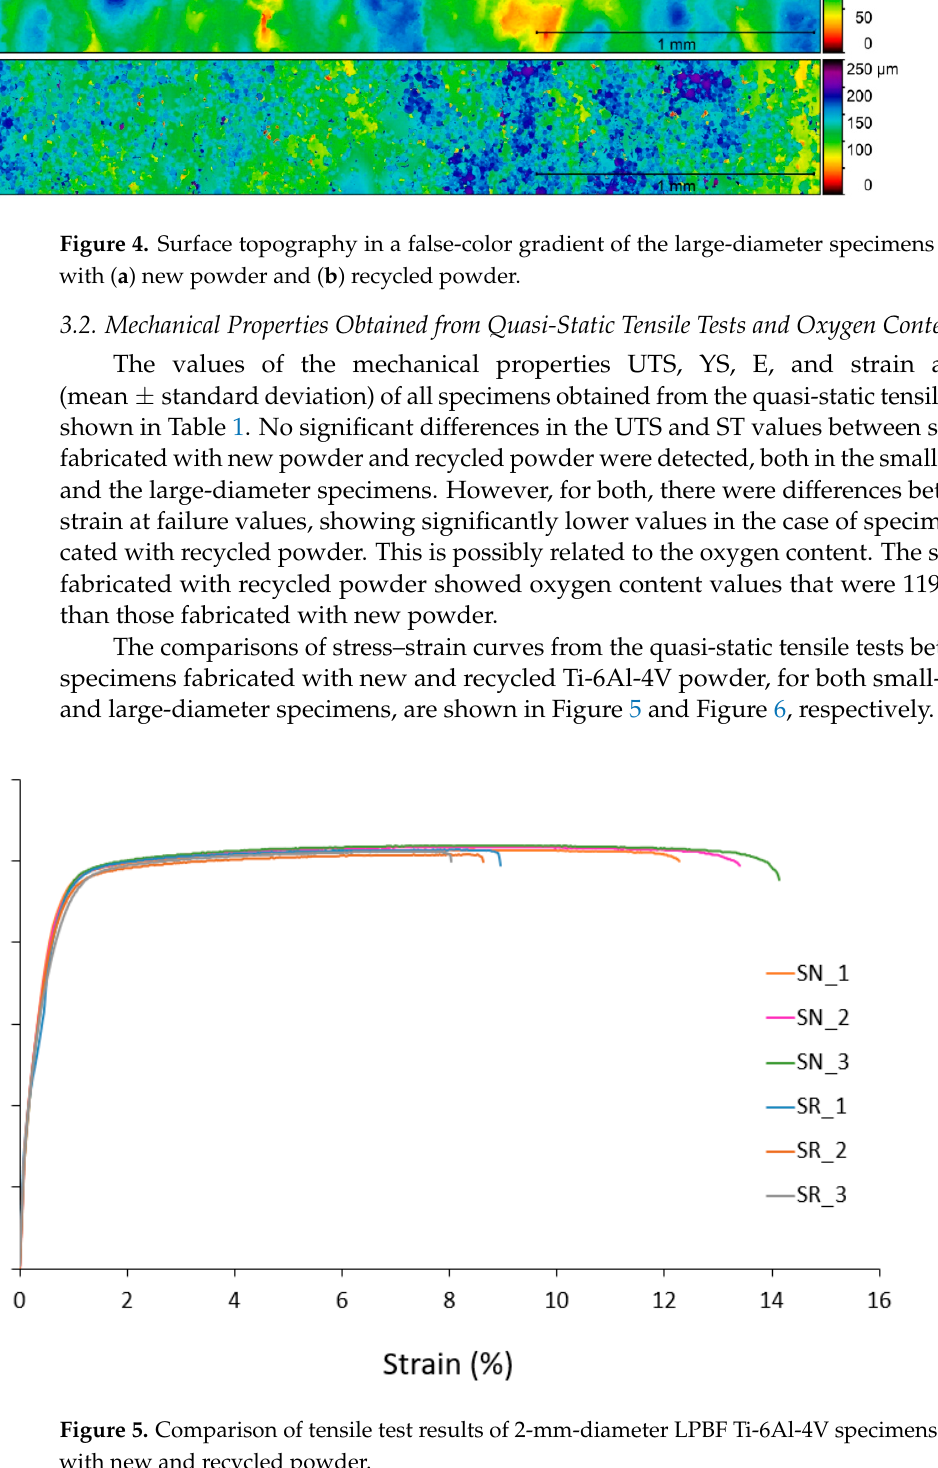
Figure 3. Surface topography in a false-color gradient of the small-diameter specimens fabricated with ( a ) new powder and ( b ) recycled powder.